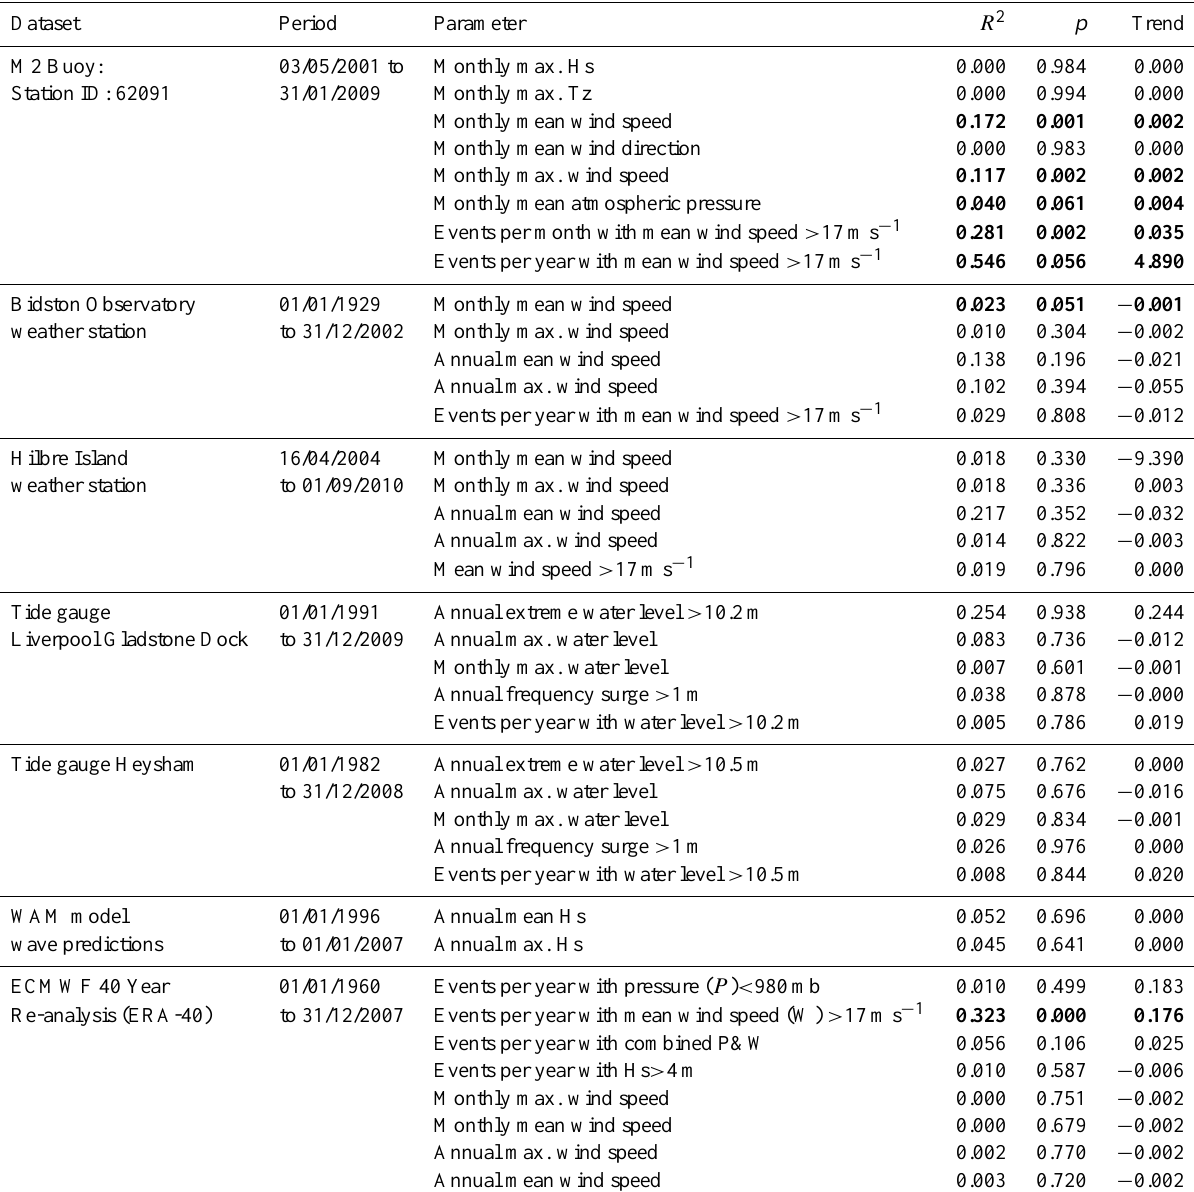
Table 1. Linear regression analysis of metocean datasets for stated periods showing Pearson product moment correlation coefficients ( R 2 ), probability of statistical significance ( p ) and linear